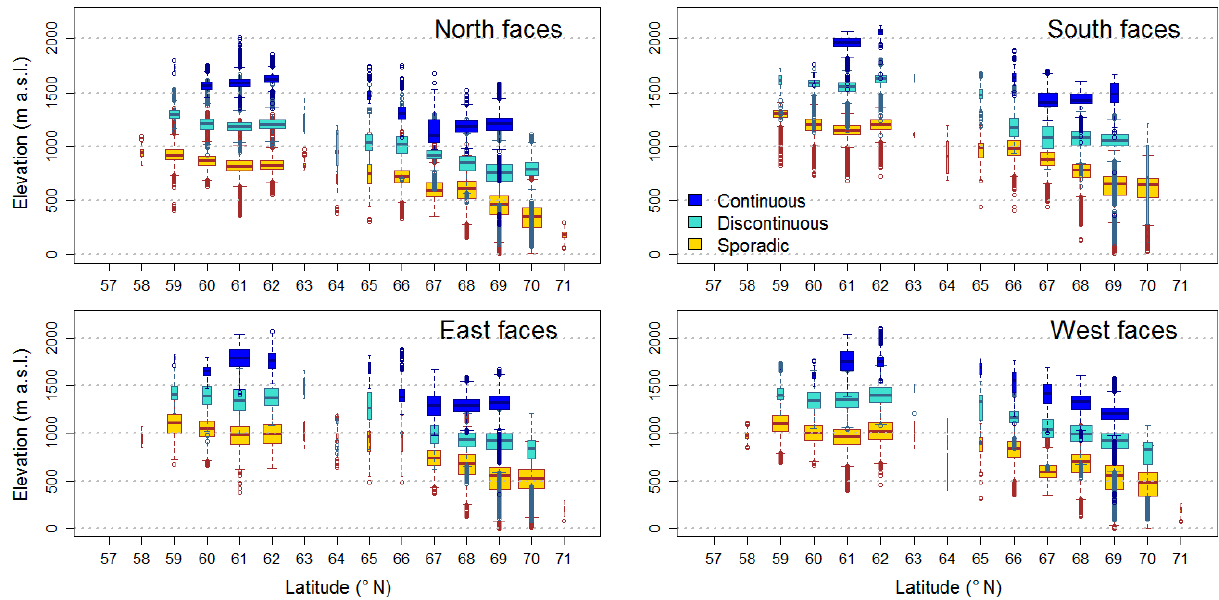
Figure 9. Distribution of the lower limit of each permafrost class according to elevation, aspect and latitude. The width of the boxes is proportional to the square roots of the number of observations in the respective groups. The lowest and highest boundaries of the boxes respectively display the 1st and 3rd quartile ( Q 1 and Q 3) of the observations. The lowest and highest whiskers respectively show Q 1 − (( Q 3 − Q 1) × 1 . 5) and Q 3 + (( Q 3 − Q 1) × 1 . 5). The dots are the